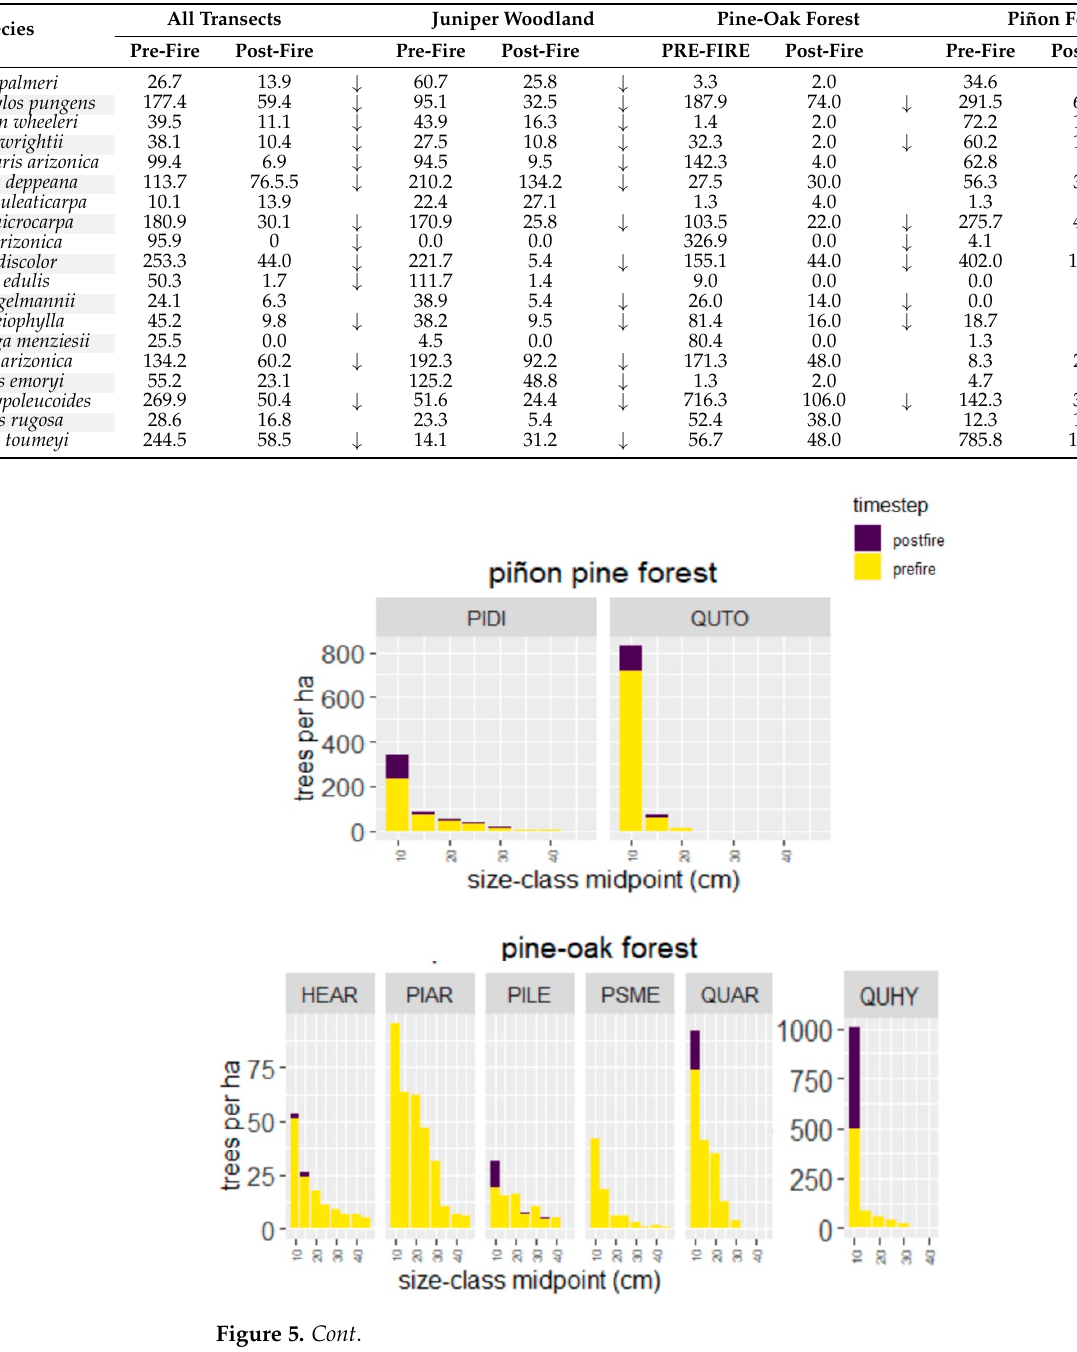
Table 4. Mean woody plant abundance (ha − 1 ) of major woody plant species in transects for pre-fire (2002/2003) and post-fire (2017/2018) in Chiricahua National Monument. Means are shown for all transects and for all vegetation types. Down arrows indicate significant declines in woody plant abundance according to paired t -tests at the α < 0.05-level. Full t-test modeling results and sample sizes are shown in Appendix B.